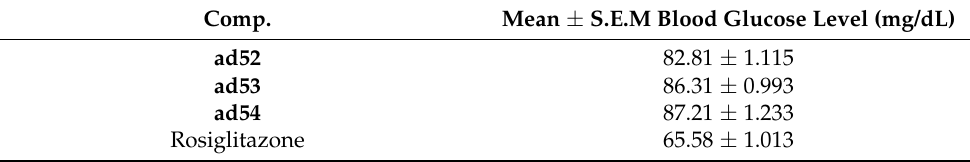
Table 52. Antidiabetic potential of the compounds ( ad52 – ad54 ). Comp.